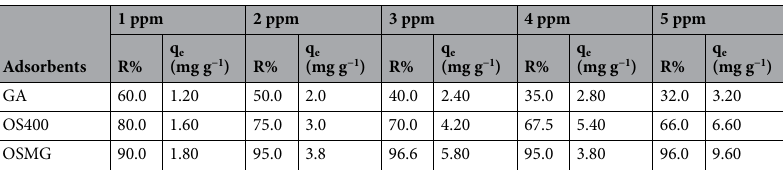
Table 4. Effect of initial concentration on (R%) and qe (mg. g -1 ) of MB dye after 100